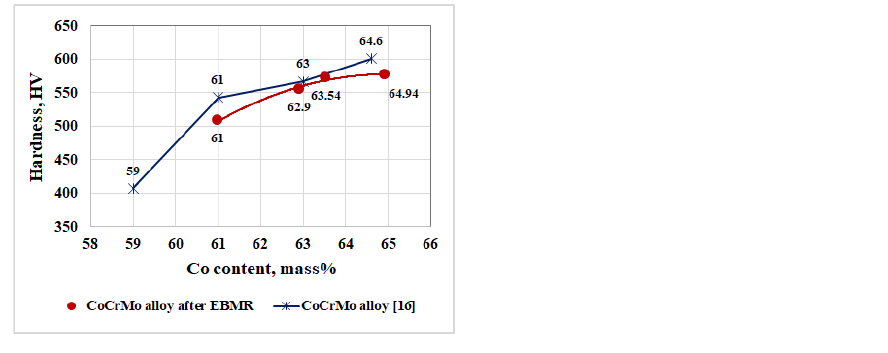
Figure 5. Influence of the cobalt content on the hardness of the produced CoCrMo specimens.